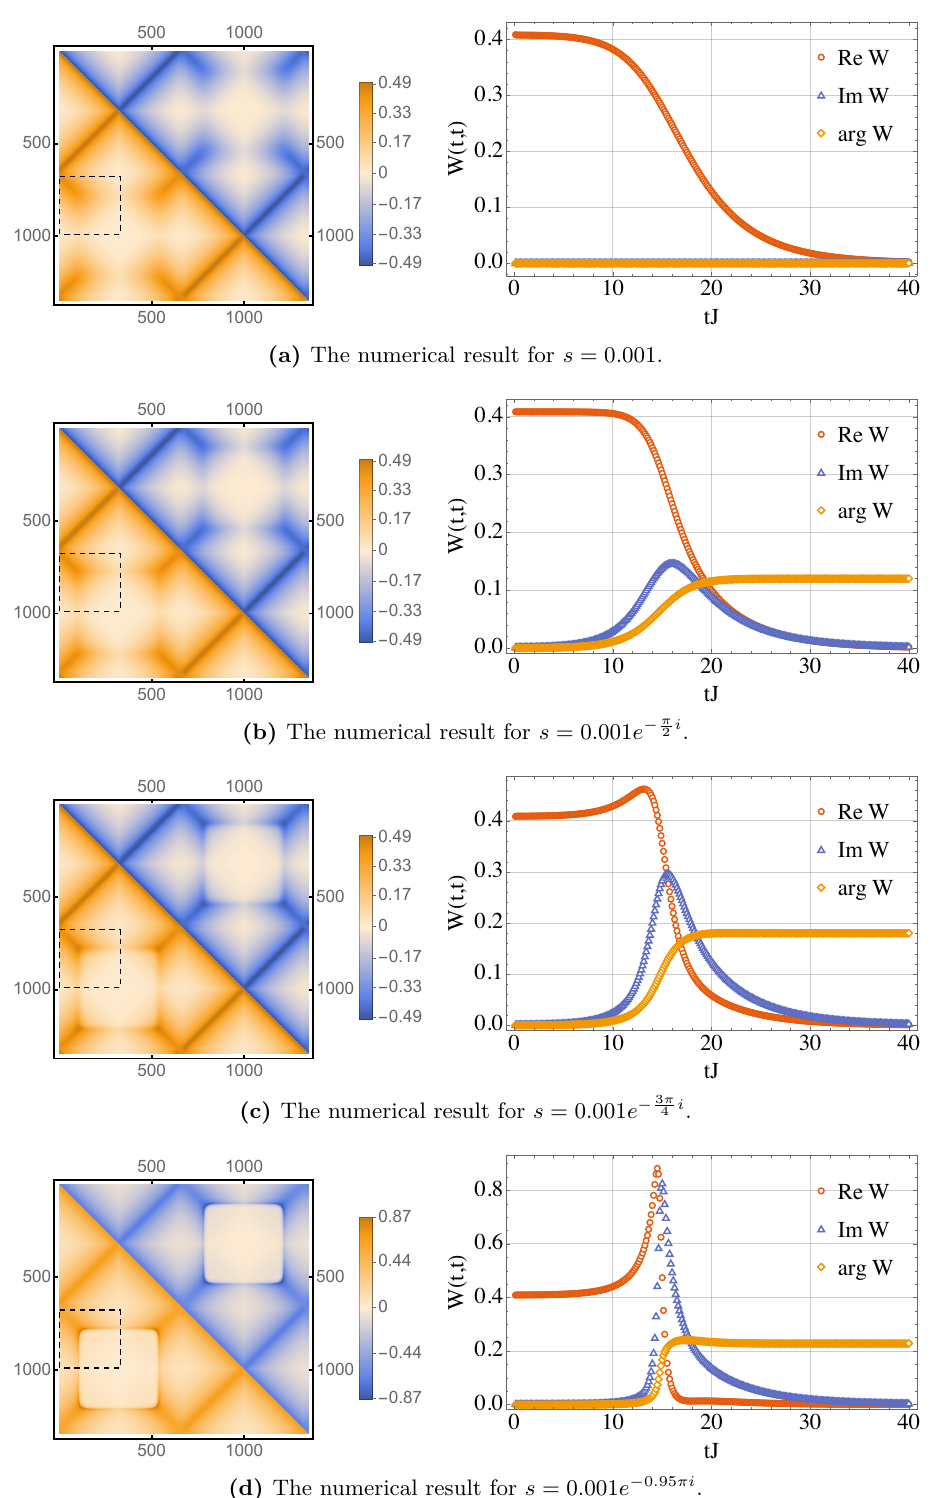
Figure 8. Numerical results for the q = 6 model with βJ = 8 and tJ = 40 . The color plots on the left show Re G ( l, l 0 ) ; the area representing W is marked by the dashed box. On the right, arg W is plotted in units of 2 π